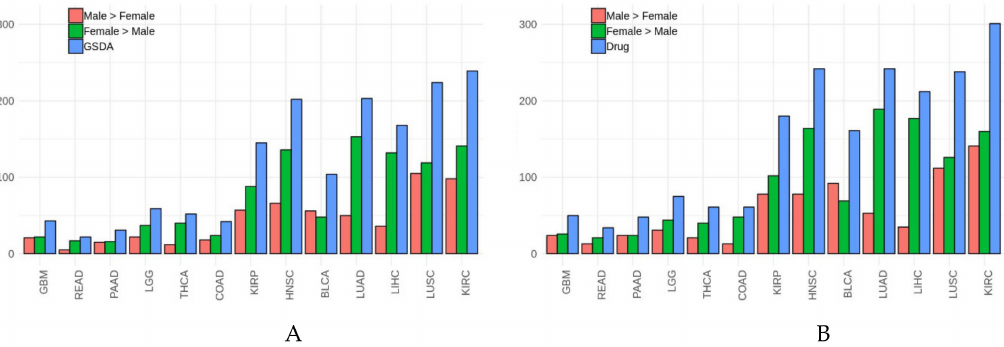
Figure 1. Number of signaling circuits with significant gender-specific di ff erential signaling activity (GS-DSA) in the di ff erent cancer types studied. ( A ) the number of circuits with significant GS-DSA in each cancer, decomposed into those in which the activity of the signaling circuit is higher in males than in females and vice versa. ( B ) after simulation of the drug treatment the number of circuits showing significant GS-DSA